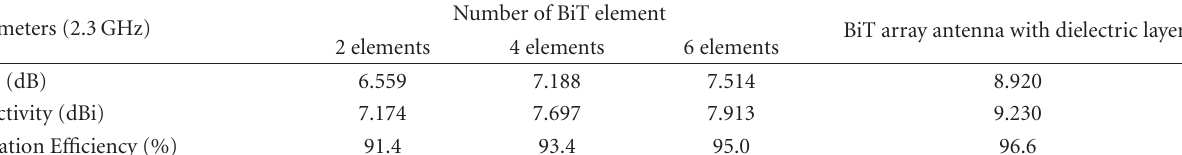
Table 2: Gain, directivity, and radiation e ffi ciency of BiT Array Antennas.